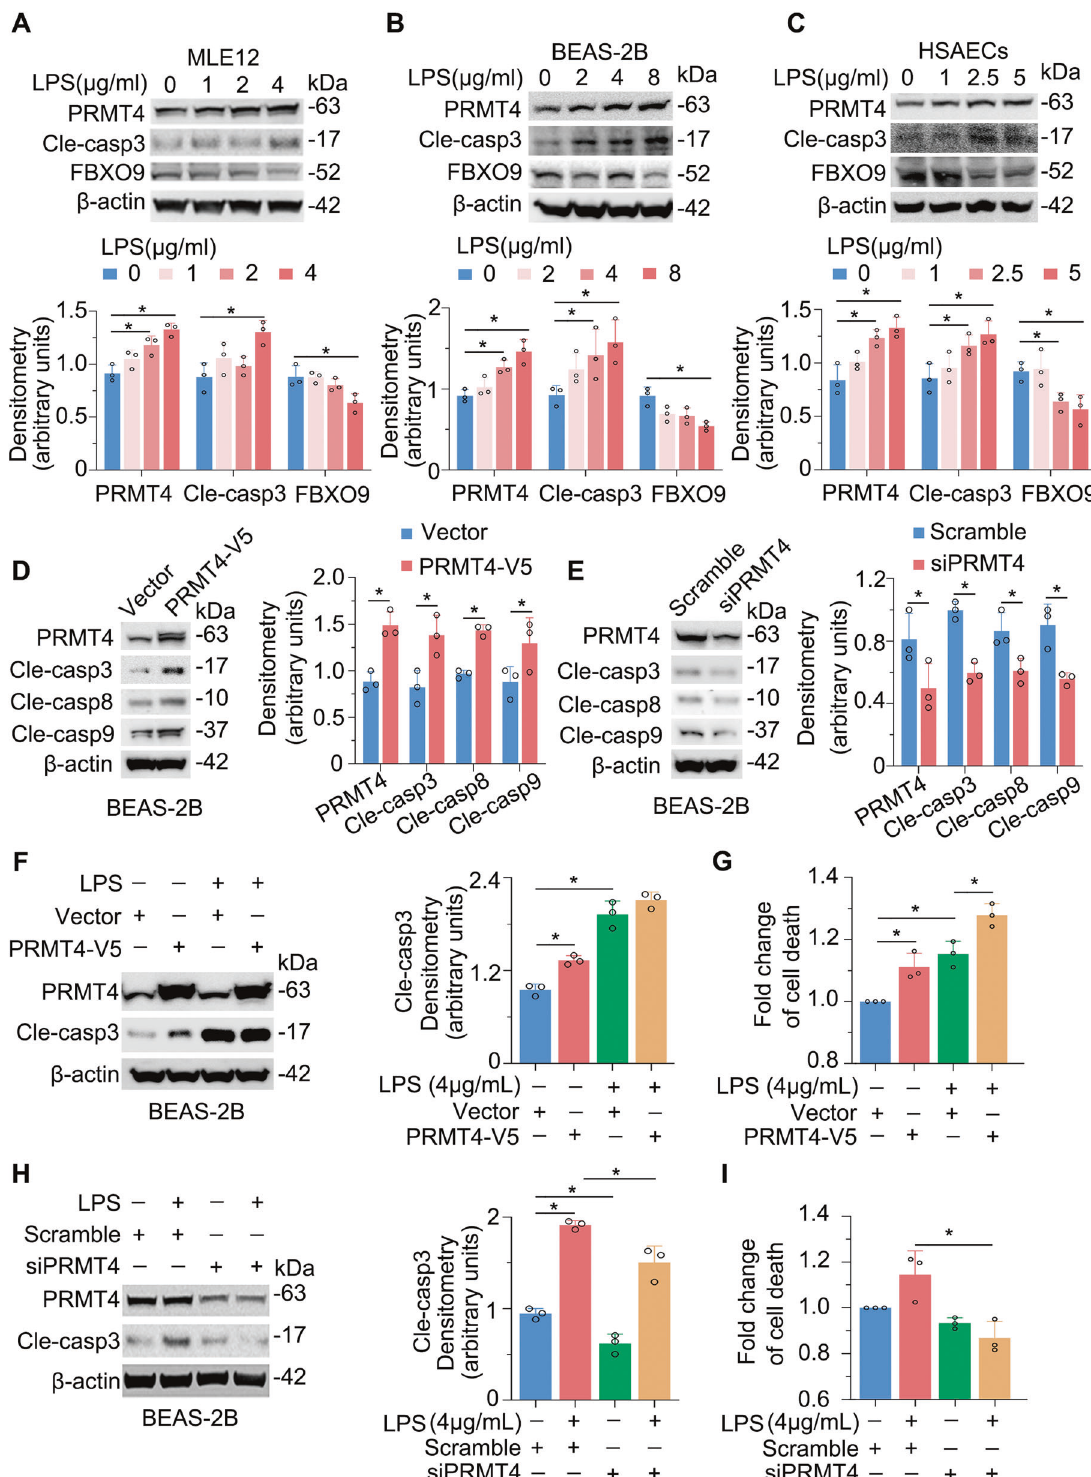
Fig. 6 Endotoxin reduces FBXO9 levels leading to PRMT4 accumulation and caspase 3 activation in lung epithelia. A – C MLE12 cells, BEAS- 2B cells, and human primary small airway epithelial cells (HSAECs) were treated with LPS as indicated. Cell lysates were analyzed by PRMT4, cleaved caspase 3, FBXO9, and β -actin immunoblotting. Shown below is densitometric analysis of immunoblots. D Overexpression of PRMT4 increases cleaved caspase 3, 8, and 9 baseline levels in BEAS-2B lung epithelial cells. E Knockdown of PRMT4 in BEAS-2B epithelial cells with shRNA reduces cleaved caspase 3, 8, and 9 expression. F , G Overexpression of PRMT4 enhances LPS-induced caspase 3 activation ( F ) and causes BEAS-2B lung epithelial cell death. Cell death is determined using LDH assay and the data are normalized with that from untreated control cells. H , I Silencing of PRMT4 inhibits LPS-induced caspase 3 activation ( H ) and cell death ( I ) in BEAS-2B cells. * P < 0.05. Experiments n = 3.